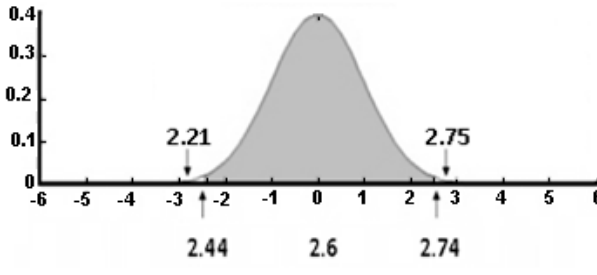
Figure 2. Representation of the intervals for the medium depression level of t he Average distance travelled in the day (km) variable.